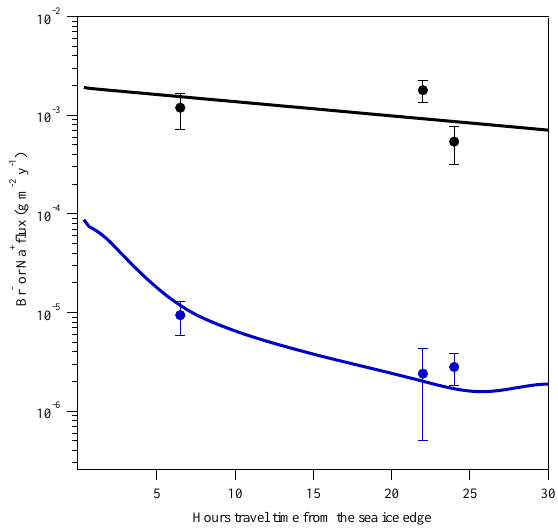
Fig. 6. Comparison between the modelled deposition fluxes for sodium (black) and bromide (blue) with measurements at Talos Dome (Circles, 7h from sea ice edge) and Dome C (Circles, 22 and 24h from sea ice